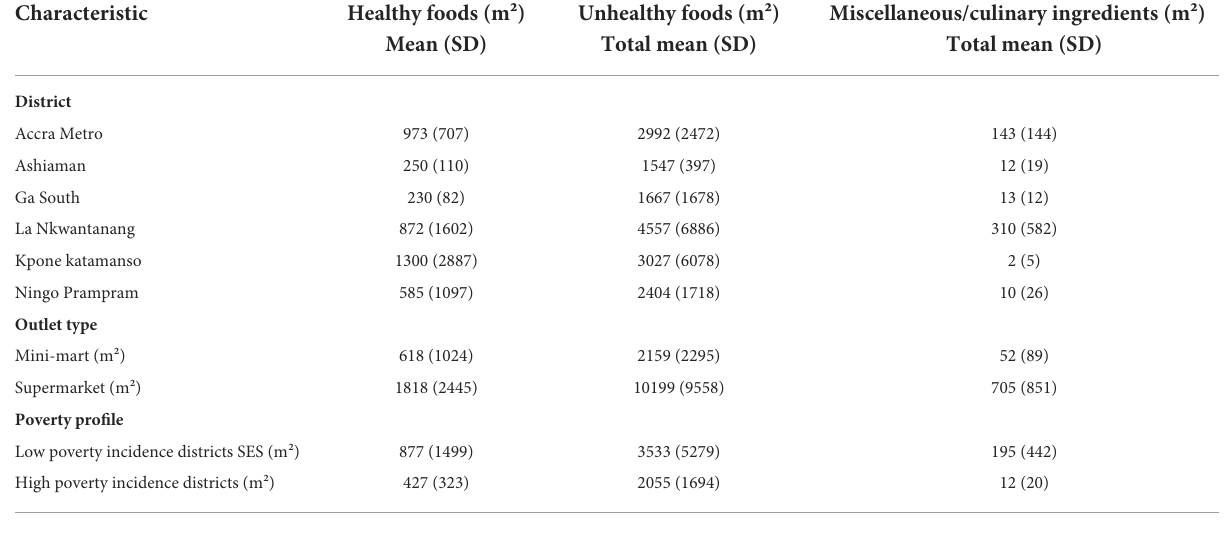
TABLE 2 Shelf area occupied by healthy and unhealthy foods in retail outlets by districts, outlet size, and district poverty level.